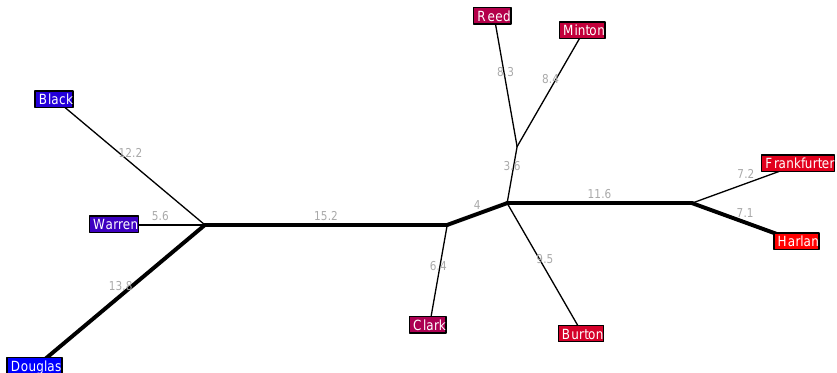
Figure 10. Judicial tree for the 1955–1956 Warren 3 Court.